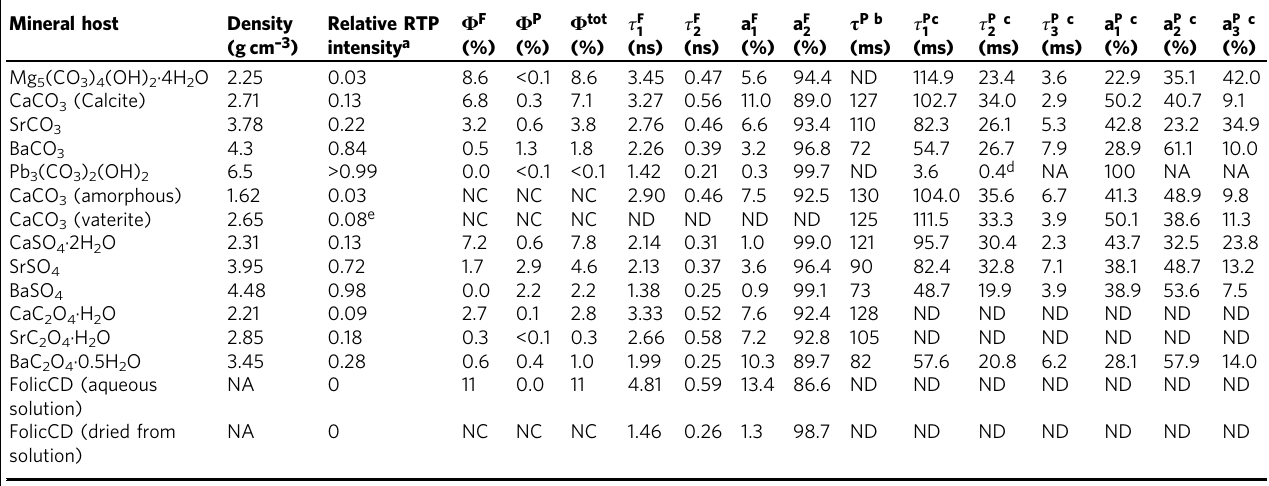
Tabulated data of density, relative RTP intensity; and fl uorescence and phosphorescence quantum yields ( Φ ), lifetimes ( τ ), and pre-exponential factors (a) ND not detected, NA not applicable, NC Not calculated, F-CND folic acid-derived carbon nanodot, PL photoluminescent, RTP room temperature phosphorescence, SS-PL steady-state photoluminescence,